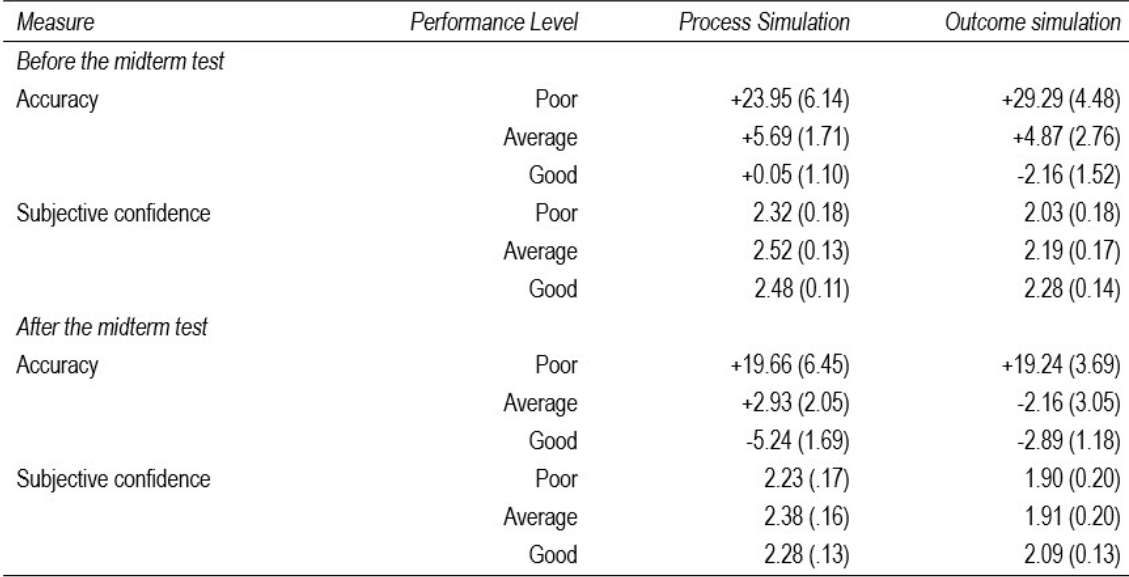
Mean and Standard Error of the Mean (in Parentheses) of Accuracy of Estimates and Subjective Confidence as a Function of Performance Level and